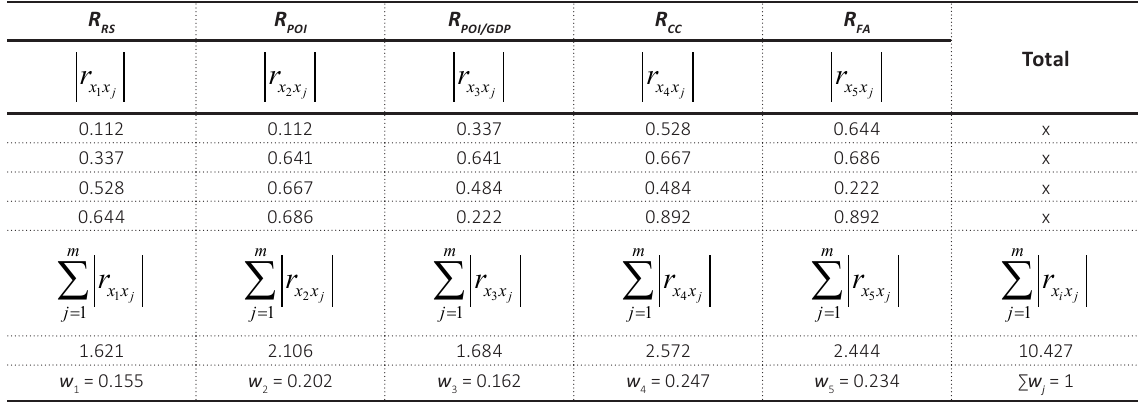
Table 8. Calculation of the weighting coefficients of individual indicators of the component of the level of fiscal policy decentralization by influence on local budget revenues formation